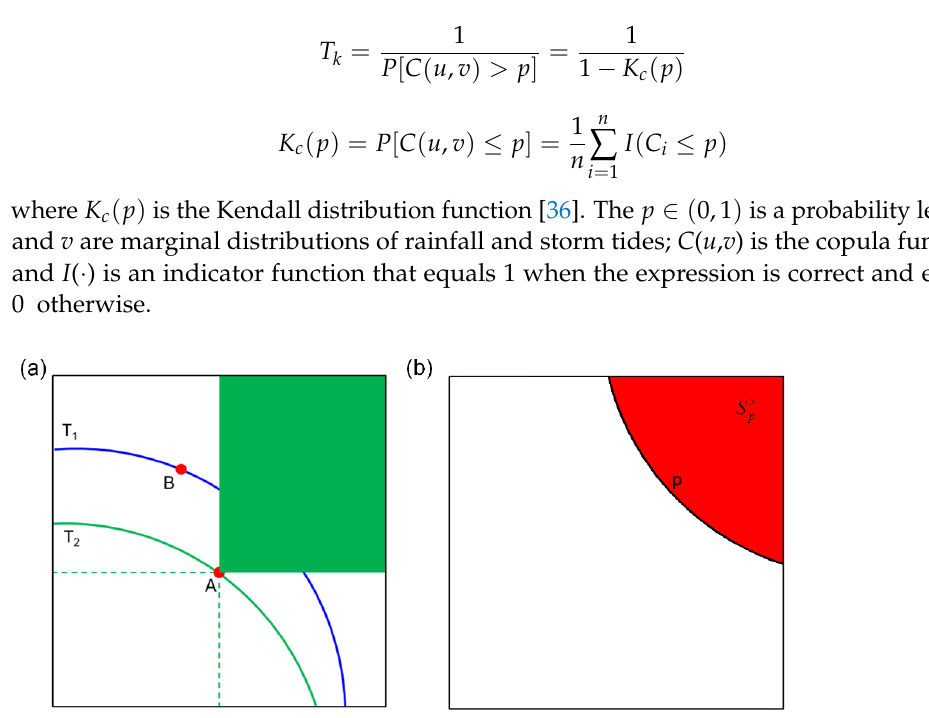
Figure 2. Graphical illustration of the dangerous region in ( a ) co-occurrence RP case; and ( b ) Kendall RP case.